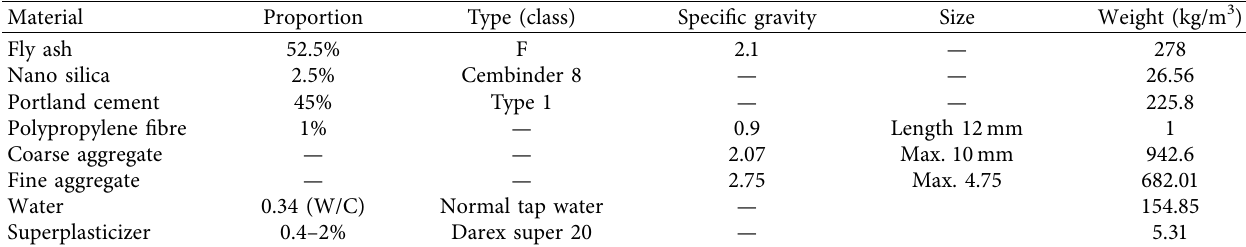
Table 1: Physical properties of the materials and mix design proportion for MYC (reinforced concrete segments using HVFANS concrete, Malaysian patent code MY-163281-A) (18).